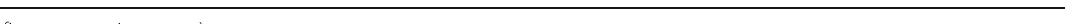
(See figure on previous page.) Fig. 4 A 38-year-old patient, presented by bilateral breast pain. a , b FFDM in CC views of both breasts: both breasts show scattered fibro- glandular parenchyma (ACR b ). Right UOQ shows rounded lesion with indistinct border and left UOQ shows oval mass with partly obscured margins (arrows). No suspicious calcifications are seen (BIRADS IV). c , d DBT CC views of both breasts. Both breasts show oval masses with well-